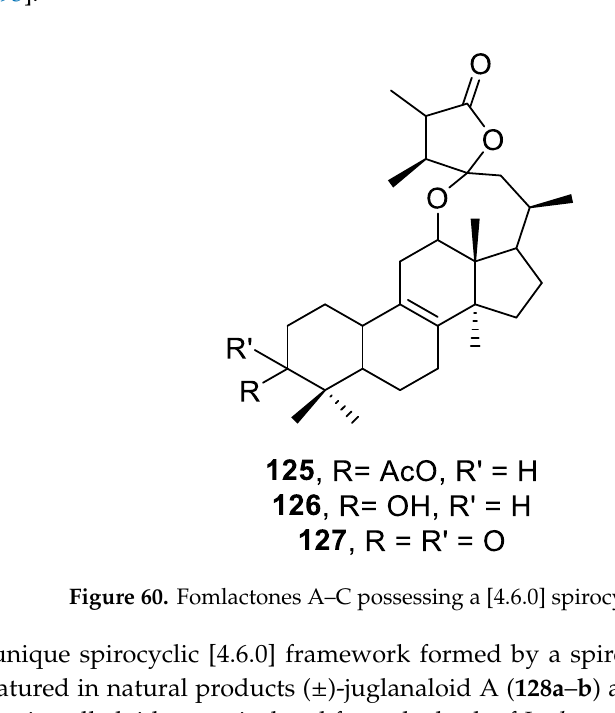
Figure 61. Enantiopure juglanaloid A ( 128a – b ) and juglanaloid B ( 129a – b ) isolated from Juglans mandshurica and further obtained by chiral separation.